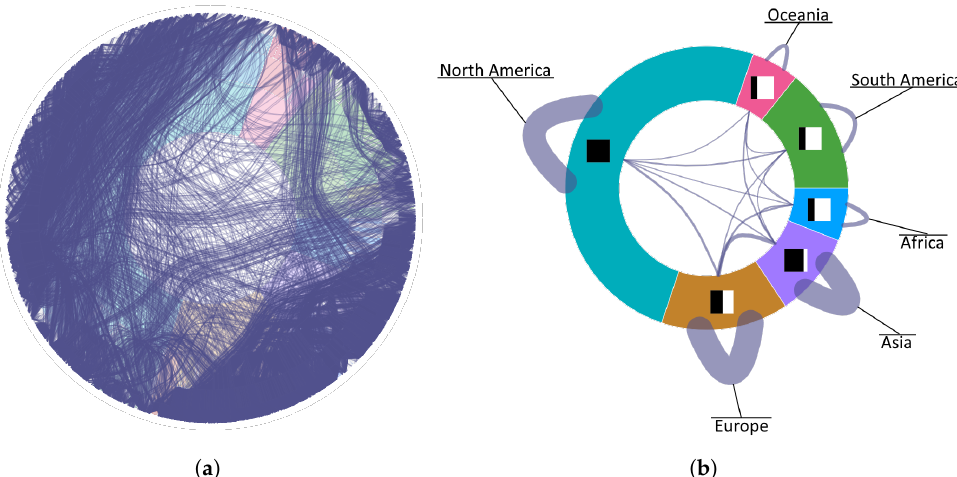
Figure 13. ( a ) Flight dataset’s initial visualization, depicting the hierarchy totally uncollapsed. Adjacency edges represent air routes among airports that are hierarchically structured into cities, regions, countries, and continents. ( b ) Dataset completely collapsed at the continent level. The angle occupied by the sectors is proportional to the number of airports. The black filling of the square placed in each sector is indicative of the connectivity degree. Asia and Europe show a high degree of connectivity in relation to their number of